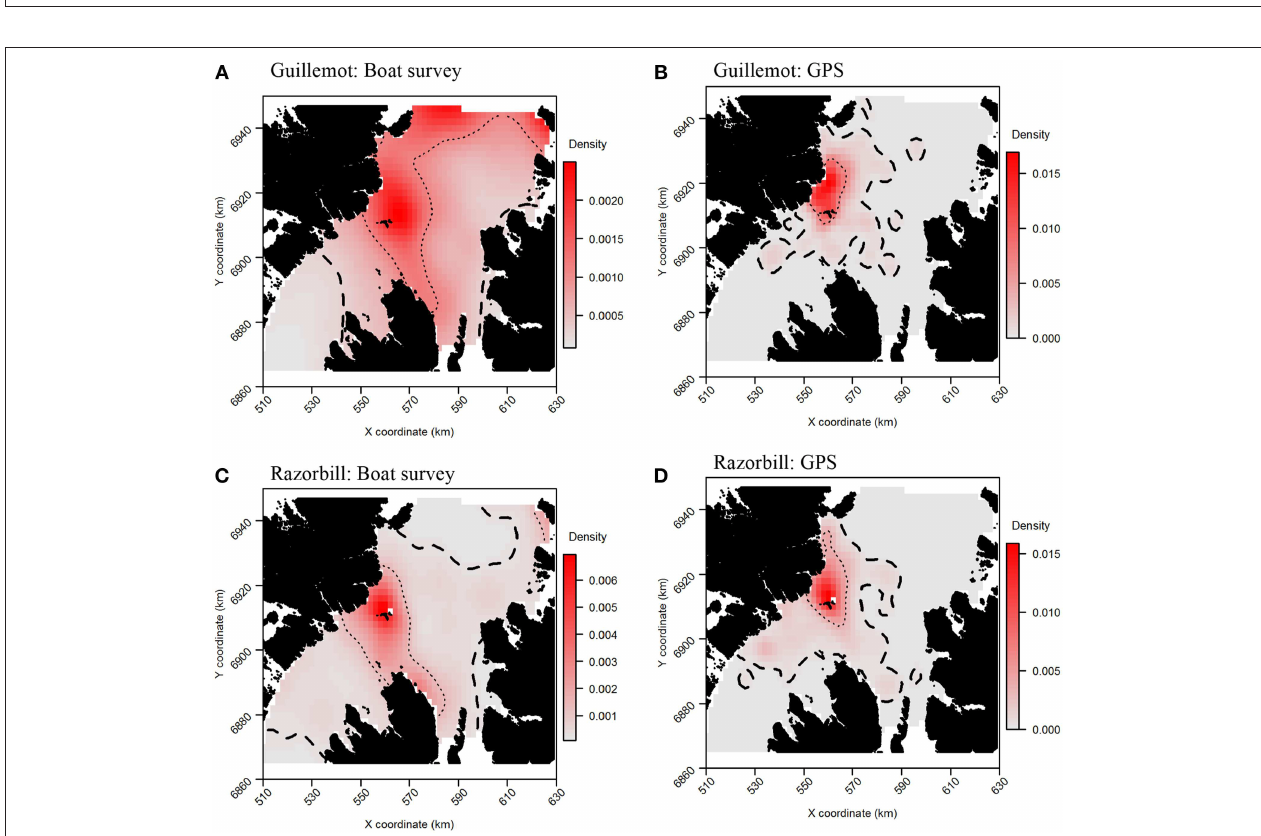
and UDOI was > 1, indicating reasonably good concordance in probability